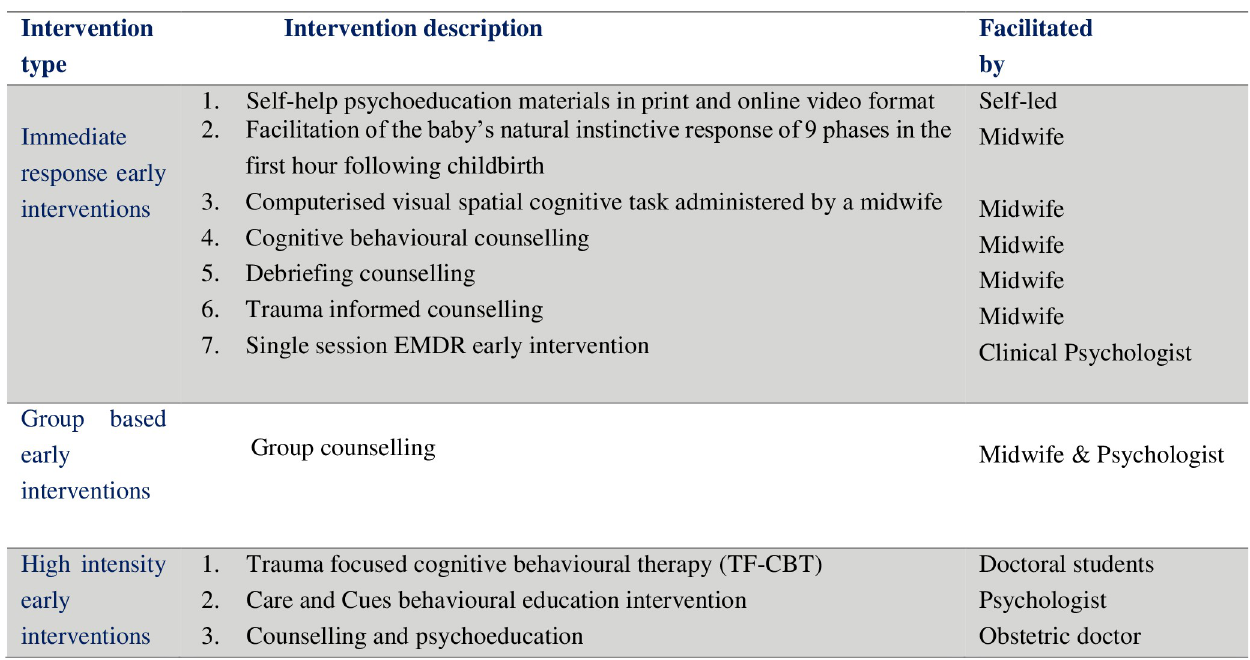
Fig 2. Early psychological interventions targeting PTSD in women following traumatic